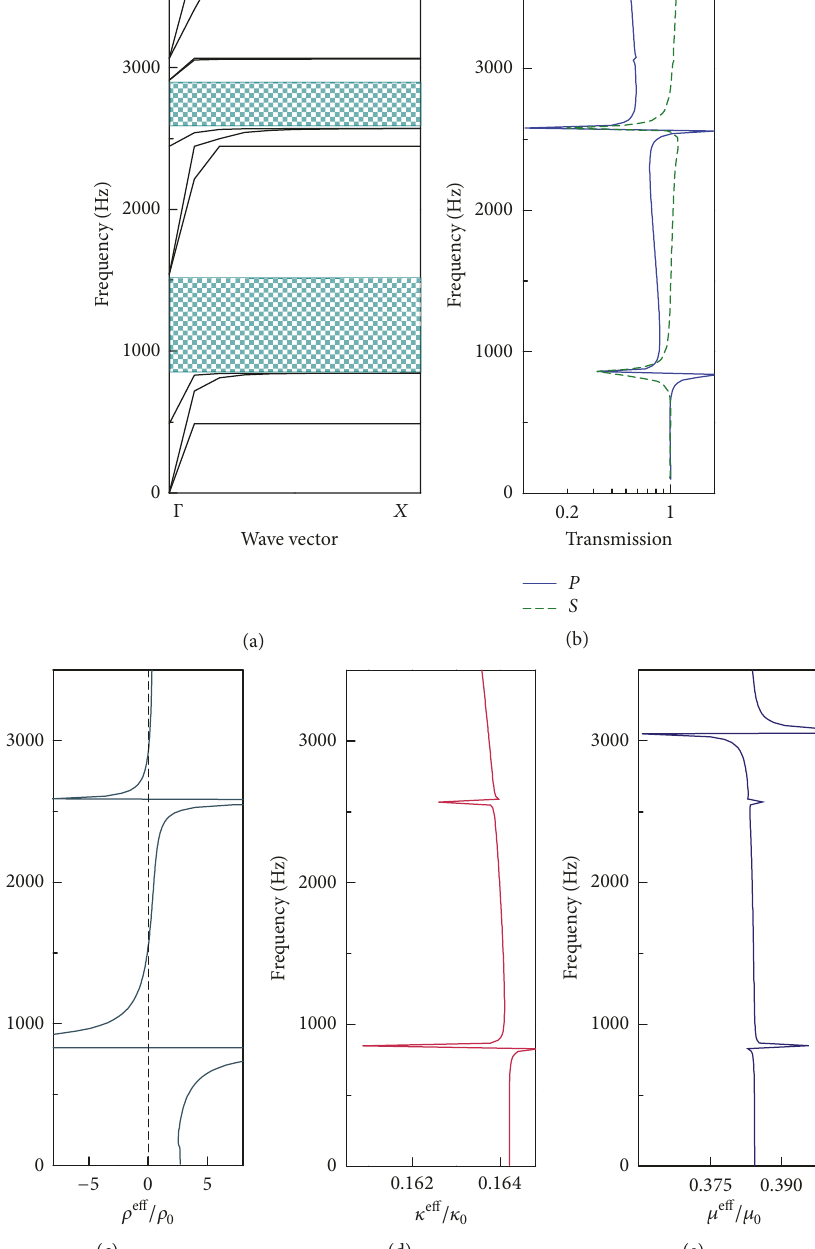
Figure 2: Band structure of single-oscillator acoustic metamaterial in the Γ𝑋 direction (a); transmission characteristic curve in the Γ𝑋 direction (b); normalized effective mass density, effective bulk modulus, and effective shear modulus (c–e). The blue regions represent the positions of band gaps. 𝑃 and 𝑆 represent a compression wave ( 𝑝 -wave) and shear wave ( 𝑠 -wave), respectively.